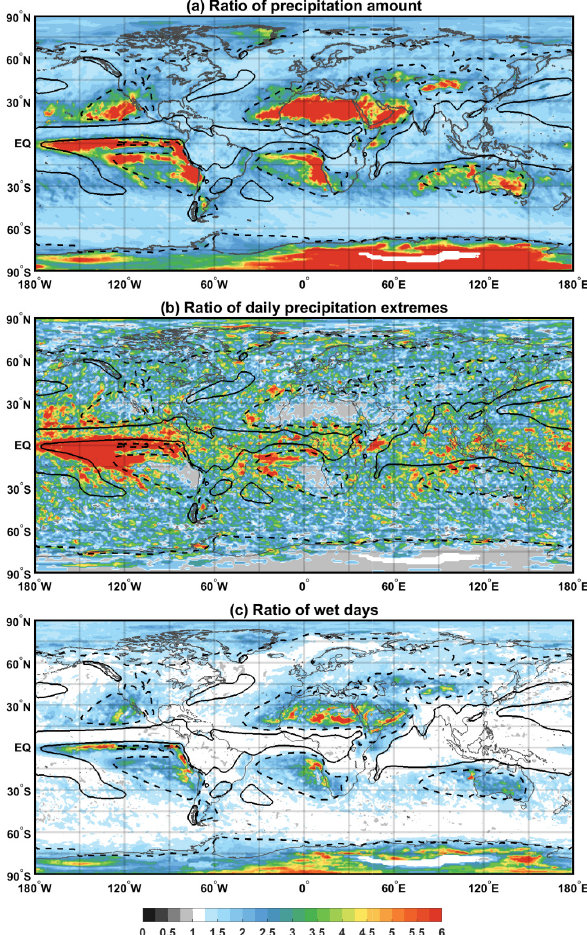
Figure 4. (a) Ratio of precipitation amount of extreme seasons with respect to the seasonal average, and (b) the ratio of the number of daily precipitation extremes included in an extreme season with re- spect to the seasonal average. (c) As (b) but for the number of wet days. Dashed and solid contours depict annual average precipitation of 500 and